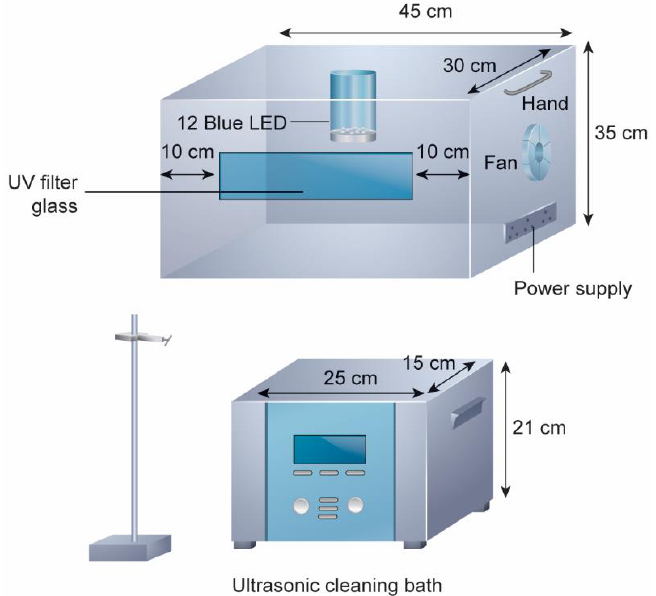
Figure 1. A schematic illustration of our designed cleaning bath sonophotoreactor (CBSPR).